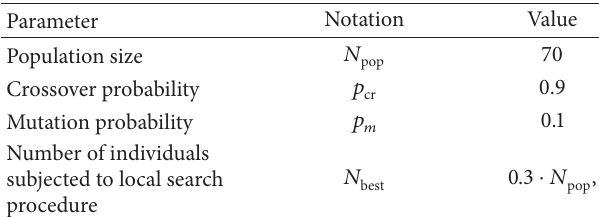
Table 3: Parameters of GHA.